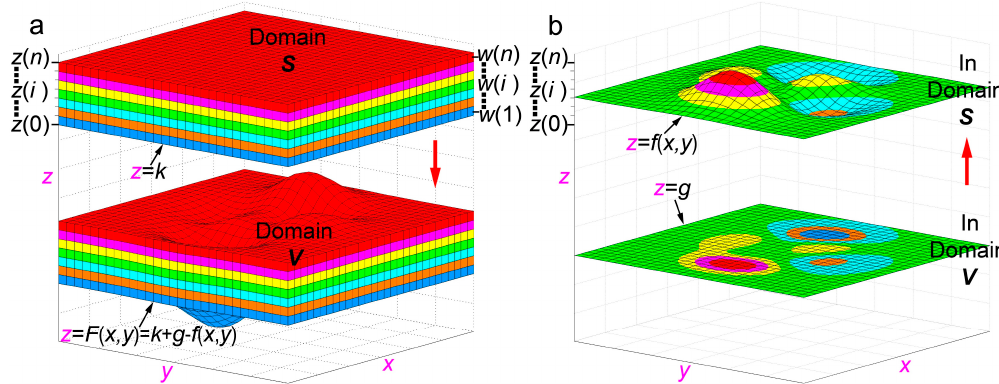
Figure 1. A mathematical transformation Q : ( x , y , z ) → ( x , y , z + g − f ( x , y )) from 3-D domain S to 3-D domain V . ( a ) 3-D domain S and 3-D domain V . Each color represents corresponding domain S ( i ) or filling material W ( i ). ( b ) The comparison of distribution of multimaterials both on the curved surface z = f ( x , y ) in domain S and that on the flat surface z = g in domain V